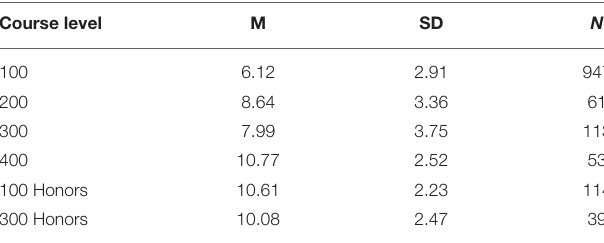
TABLE 3 | Descriptive statistics for NACK scores for different course